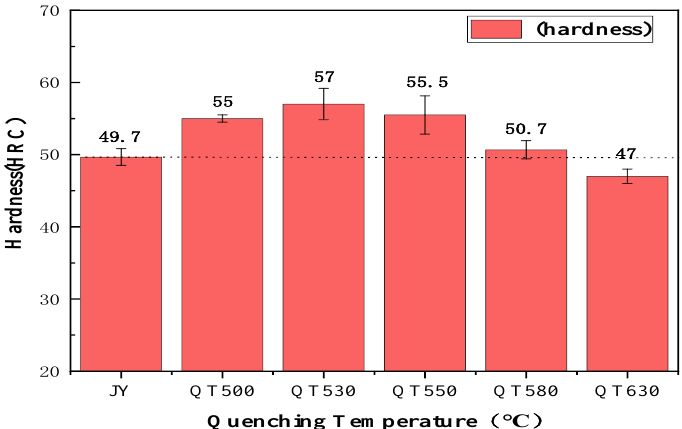
Figure 5. Hardness of HCCI samples treated at different quenching temperatures.